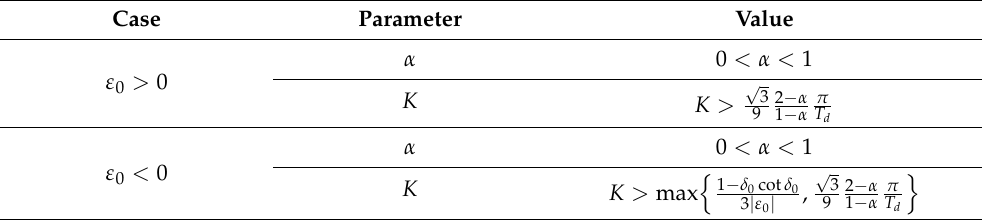
Table 1. Criteria for the selection of values of α and K .